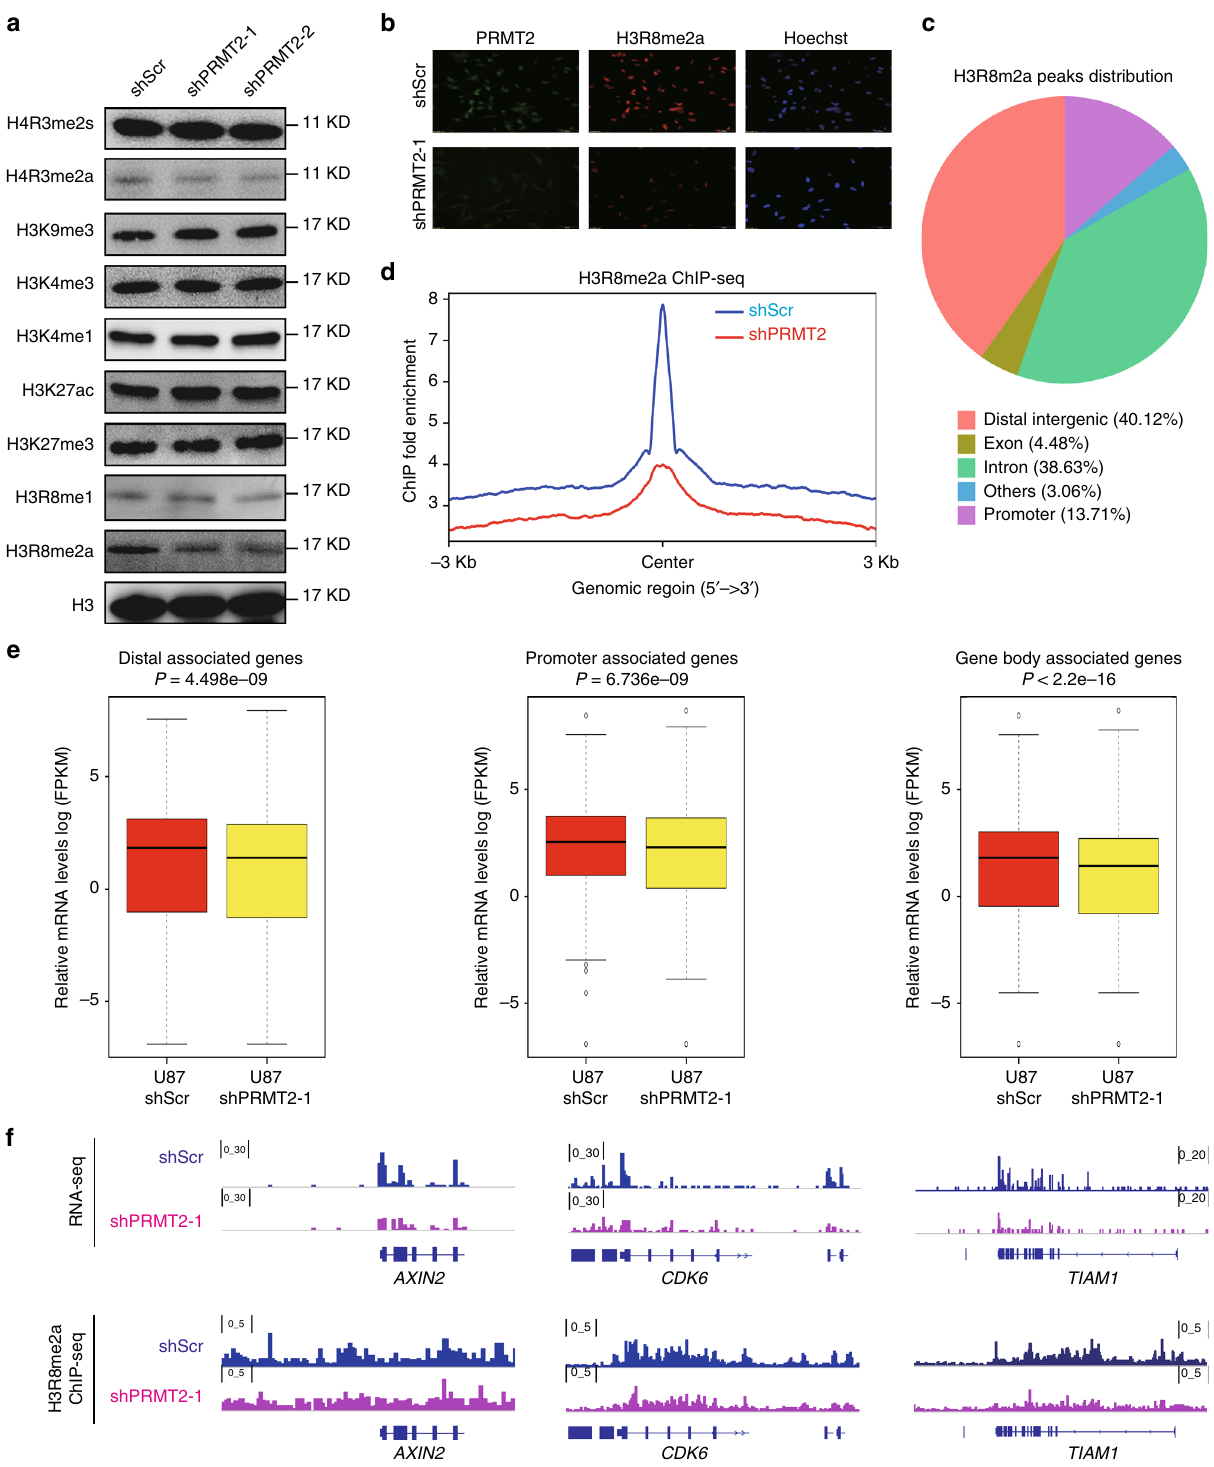
Fig. 5 PRMT2 is responsible for the maintenance of H3R8me2a levels and target gene activation. a WB analysis of designated histone modi fi cation levels in U87 cells expressing shScr or shPRMT2. Histone 3 was used as loading control. b Representative IF images of U87 cells with PRMT2 and H3R8me2a antibody. Scale bar, 50 µ m. c Piechart shows the proportion of total H3R8me2a peaks in the indicated regions. d Average pro fi les of H3R8me2a across a genomic window of ± 3000 bp surrounding the peak summit in shScr an shPRMT2. H3R8me2a peak number 13,078 in U87 shScr, 11,374 in U87 shPRMT2. e Comparison of PRMT2 target gene expression in U87 cells expressing shScr and shPRMT2. The PRMT2 target genes are divided into three subgroups (promoter, distal, gene body) according to the distribution of PRMT2-dependent H3R8me2a peaks. The bottom and the top of the boxes represent the fi rst and third quartiles respectively. Lines within boxes indicate medians. Whiskers represent the most extreme data within 1.5 times of the interquartile range. Circles represent outliers. The P -values are calculated by Wilcoxon ’ s signed-rank test. f Genomic snapshots of RNA-seq analyses (top panel) and H3R8me2a ChIP-seq analyses (bottom panel) of representative genes in U87 shScr and shPRMT2